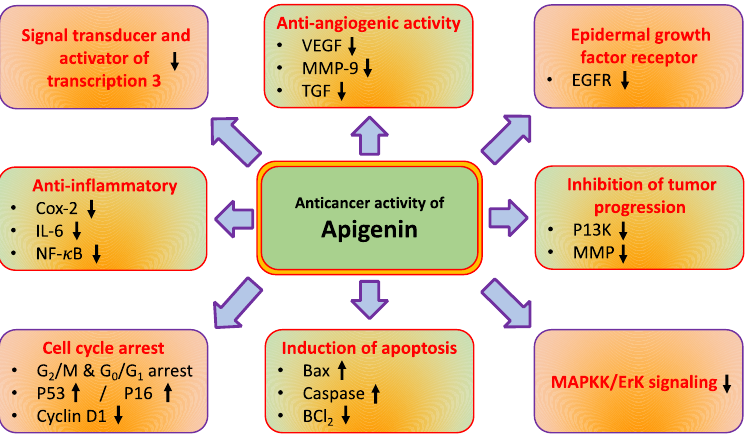
Figure 2. Apigenin’s role in cancer management through modulating cell signaling pathways. The complex cell nature of cancer is characterised by a number of complex molecular interactions and mechanisms. Table 1. Major mechanism of apigenin in cancer management through modulating gene activity. Genes Mechanism Refs.